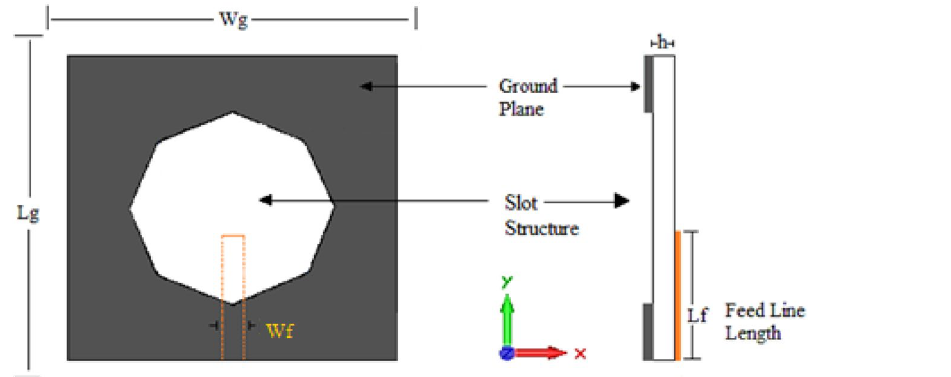
Figure 3. Antenna3 topology.